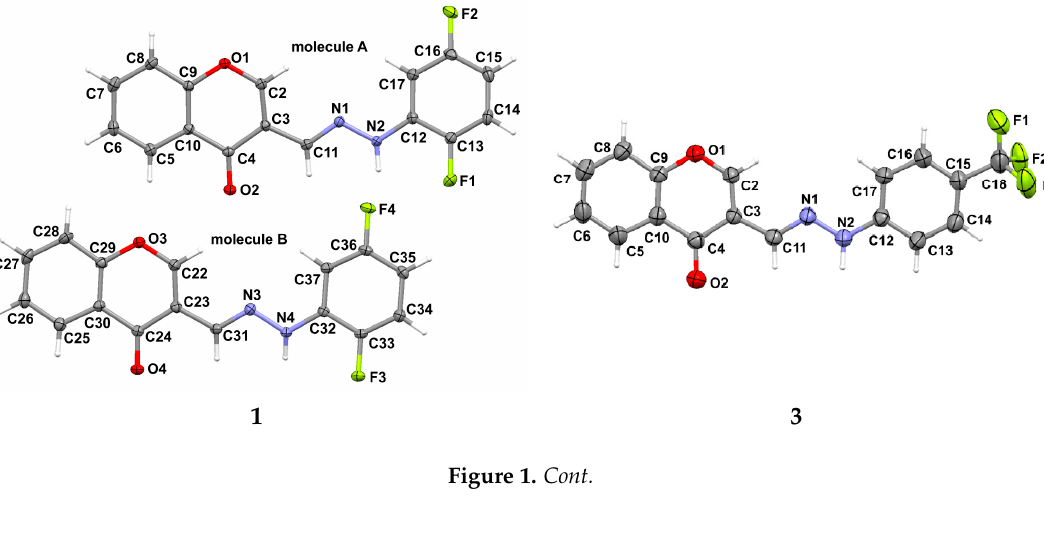
Scheme 1. Synthesis of hydrazine and hydrazide derivatives of 3-formylchromone. Reaction